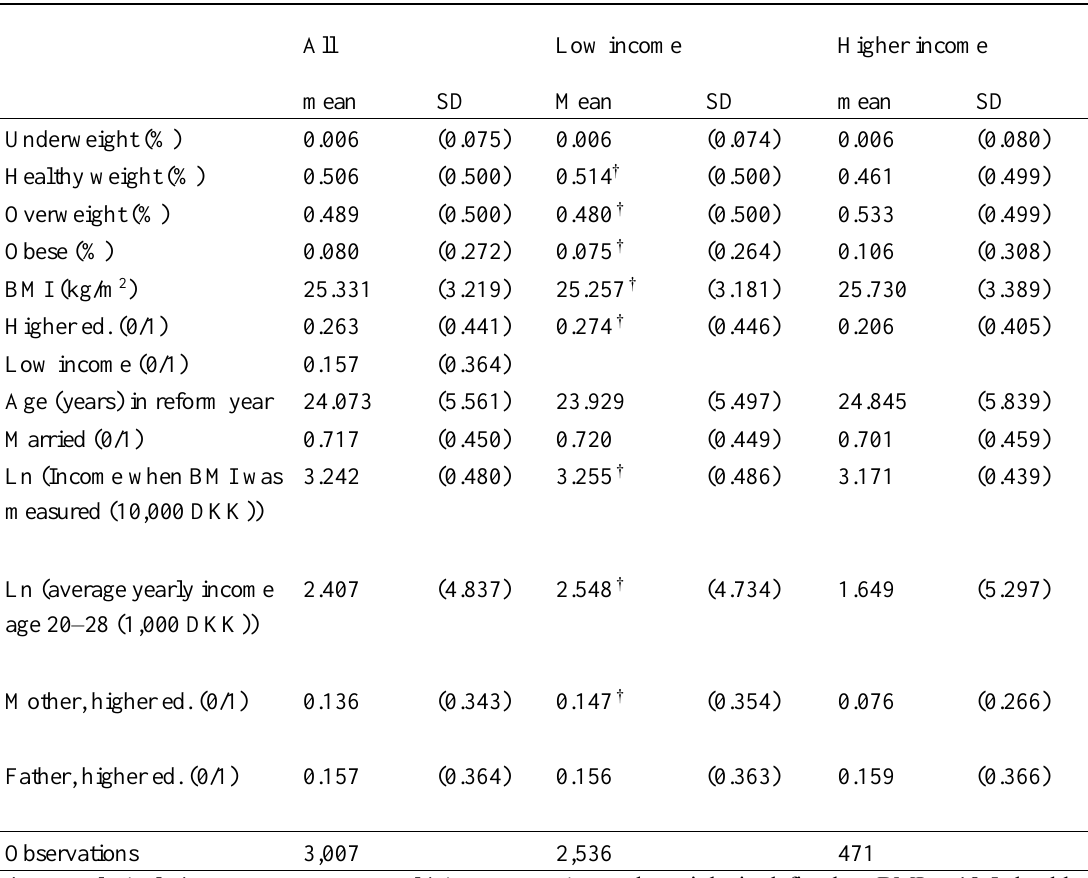
Descriptive statistics, all men and men according to parental income background. Year 1995 and 2000. Mean and standard deviation (SD) in